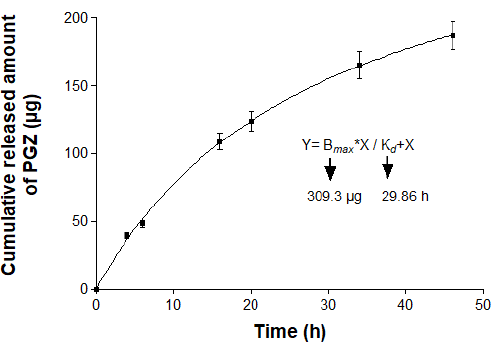
Figure 3. In vitro release profile of pioglitazone (PGZ) from nanoemulsion (NE). Data represented by mean ± standard deviation (SD) ( n =3).